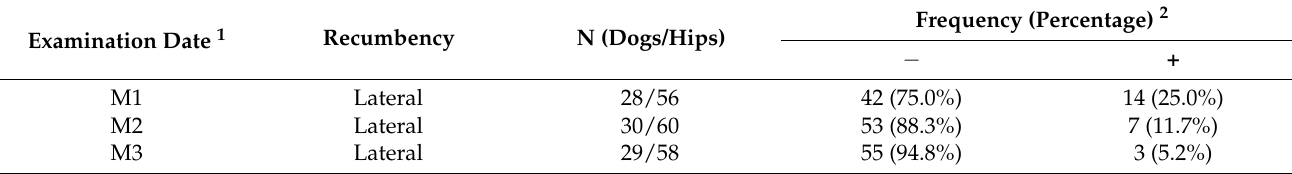
Table 3. Descriptive statistics of the Bardens tests reported for each examination